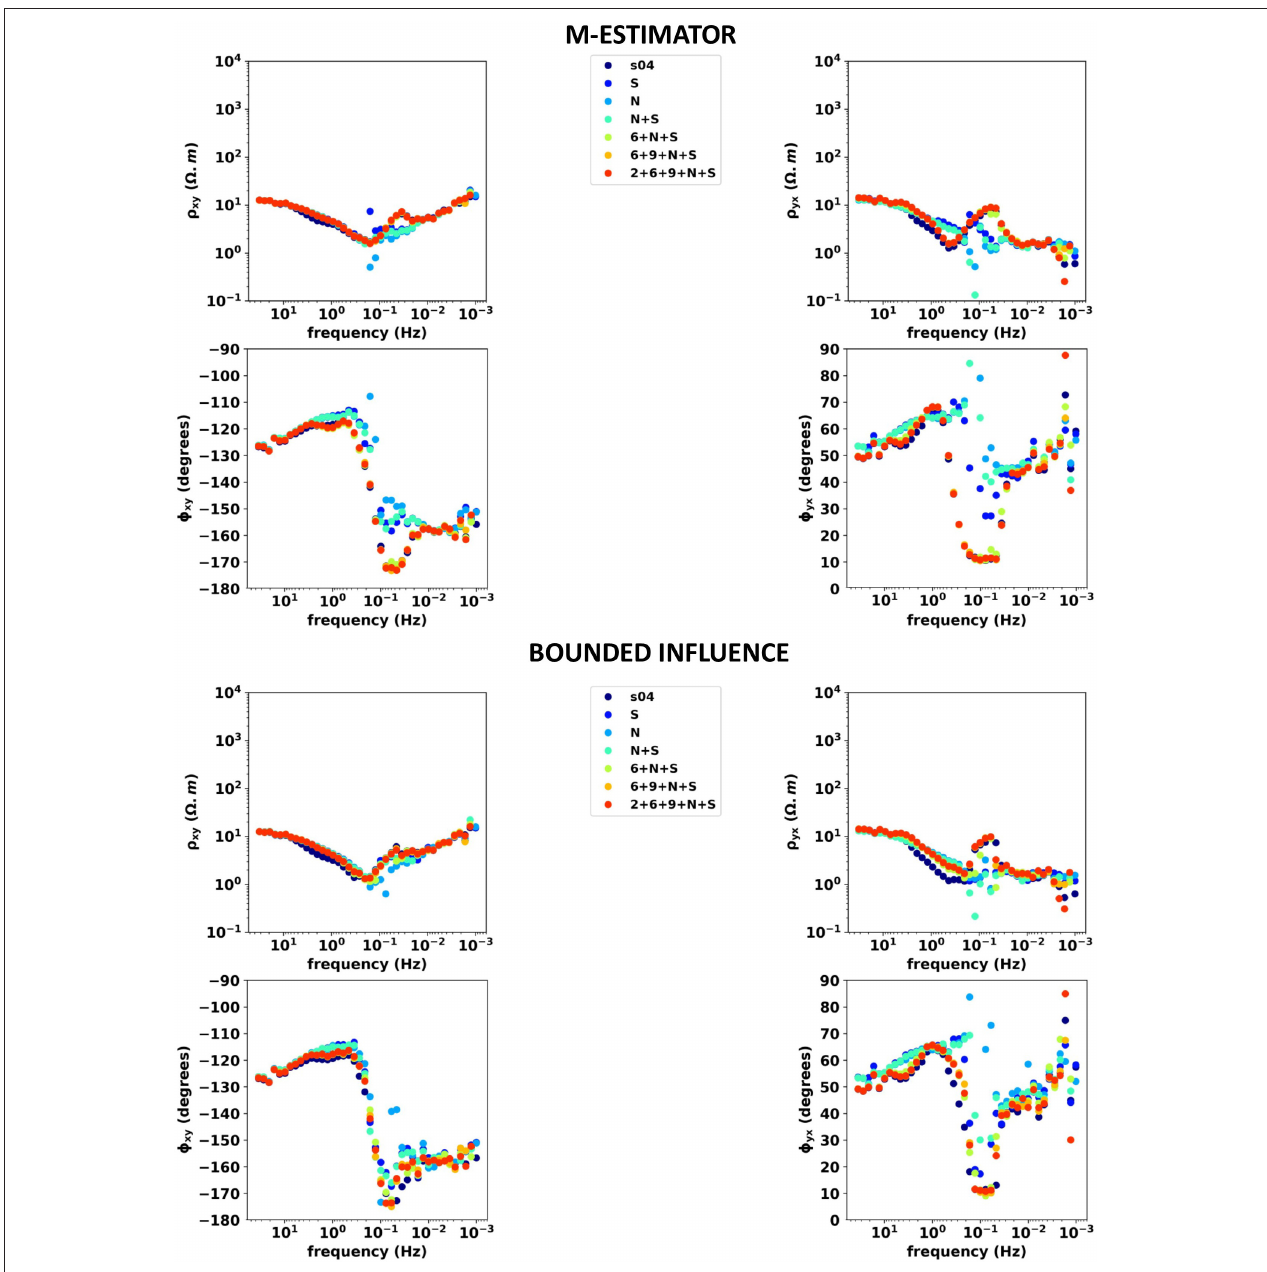
FIGURE 9 | Upper section: selected M-estimator results. SITE 04 with local RRs 2, 6, and 9 and distant RRs Welschbruch (RR100) and Schwabwiller (R99). No error bars. TF estimates for a selection of combinations of RR stations. Apparent resistivity curves ρ xy (top left) and ρ yx (top right) and phases φ xy (bottom left) and φ yx (bottom right) are shown in dots, with a color code corresponding to the associated combination of RR stations(the associated legend is displayed on the center). Lower section: selected Bounded Influence results. Same legend as